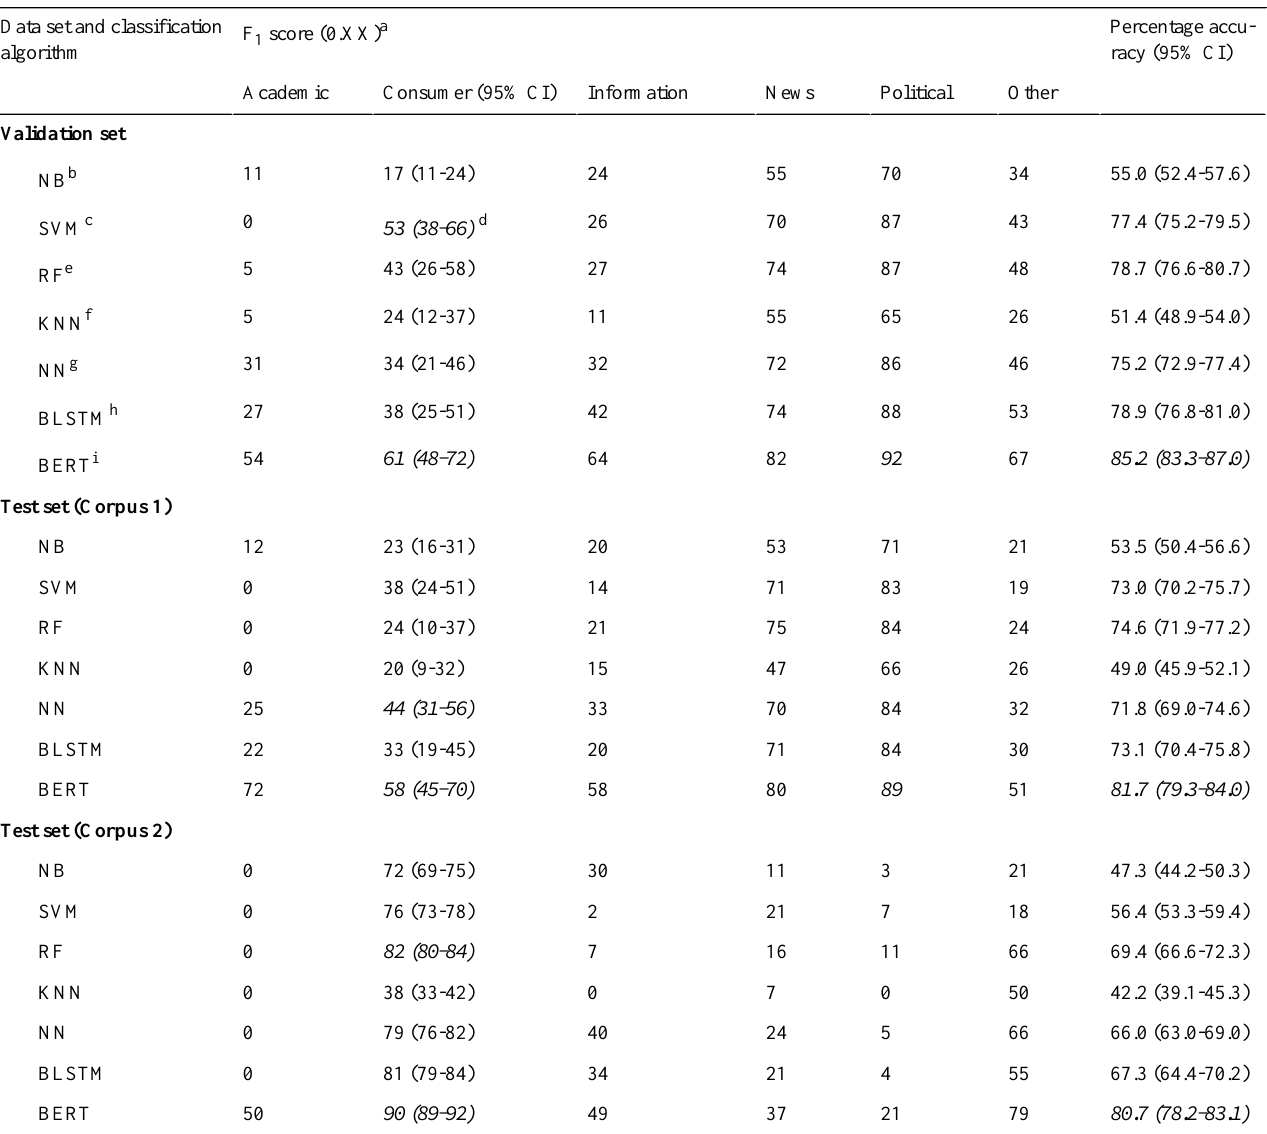
Table 2. Classification performances of the classifiers on the test sets of Corpus 1 and Corpus 2.